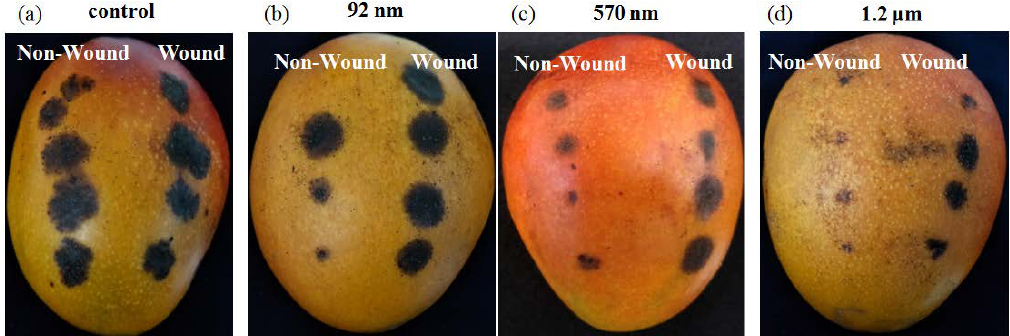
Figure 9. E ff ects of Ag particle size on anthracnose of mango: ( a ) control, ( b ) 92 nm, ( c ) 570 nm and ( d ) 1.2 µ m.